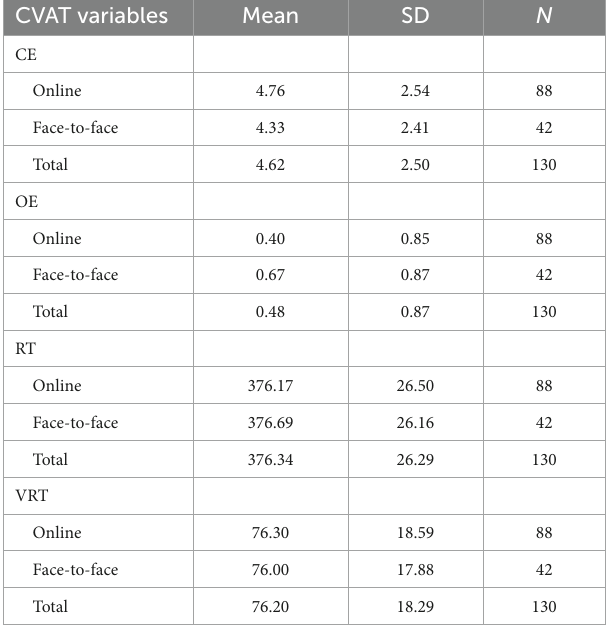
TABLE 3 Descriptive results of the CVAT for the American participants according to the testing modality (online vs. face-to-face). CVAT